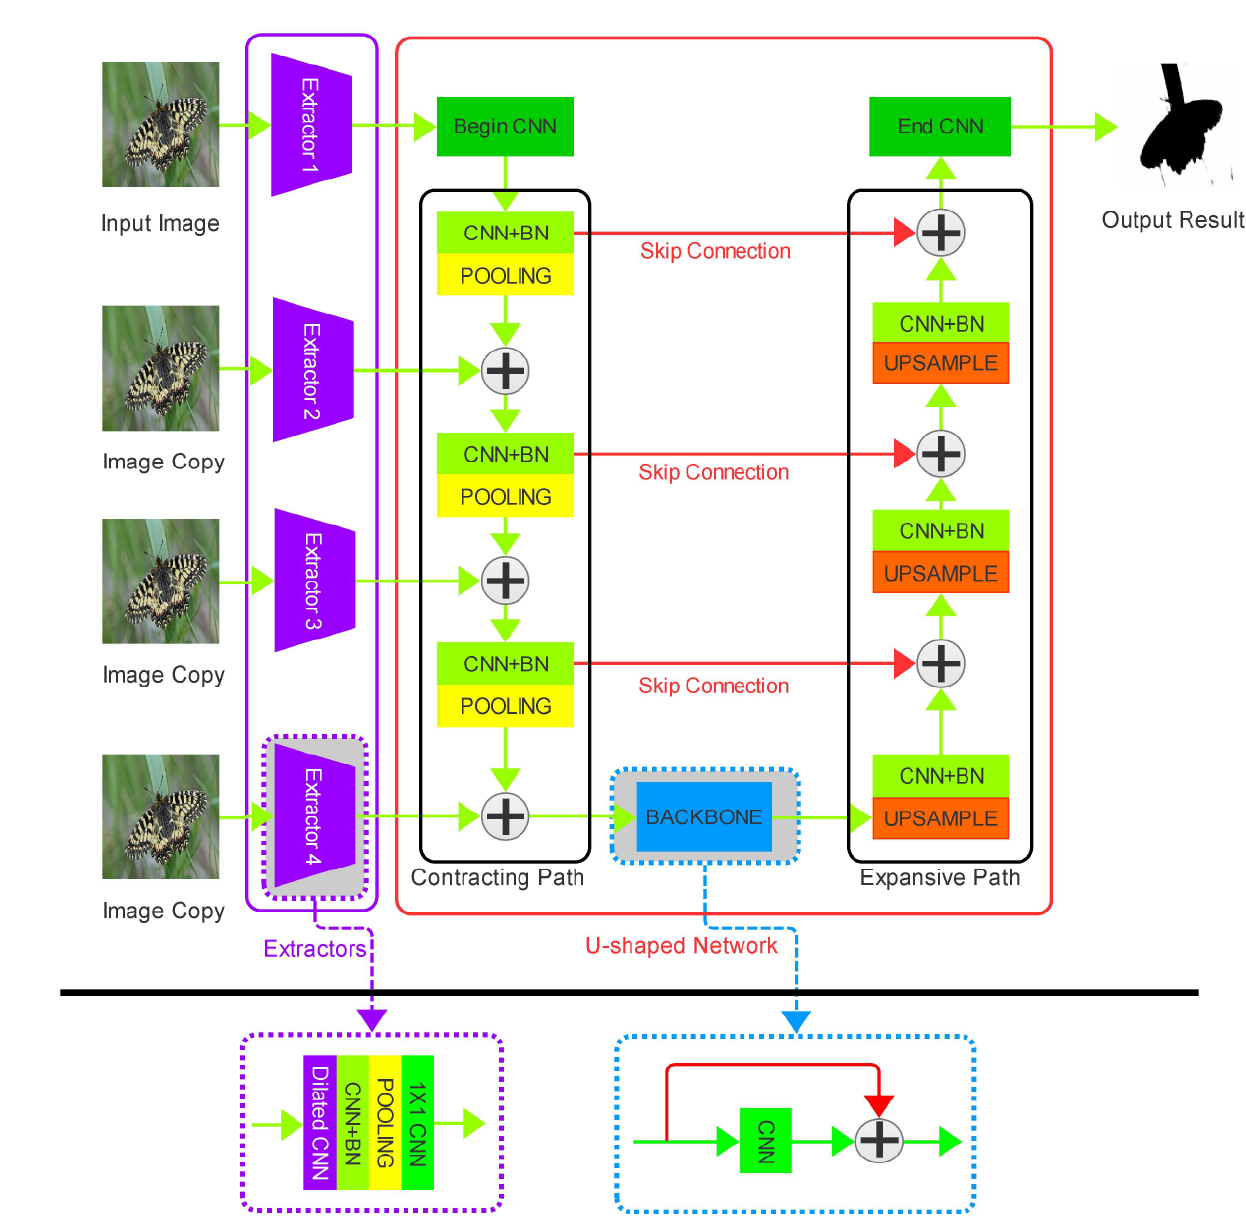
Figure 1. Detailed diagram of our model. Our model can be divided into two parts: a group of feature extractors are shown in the purple box and the U-shaped network is shown in the red box. In the U-shaped architecture, it can be divided into the contracting path, the expansive path, and the backbone. All the “+” signs in the figure mean connecting the two parts of feature in the channel dimension. Different colors of the blocks mean that the blocks have different functions: green blocks mean convolution; yellow blocks mean pooling; orange blocks mean upsampling; light green blocks mean convolution and batch normalization; purple blocks mean dilated